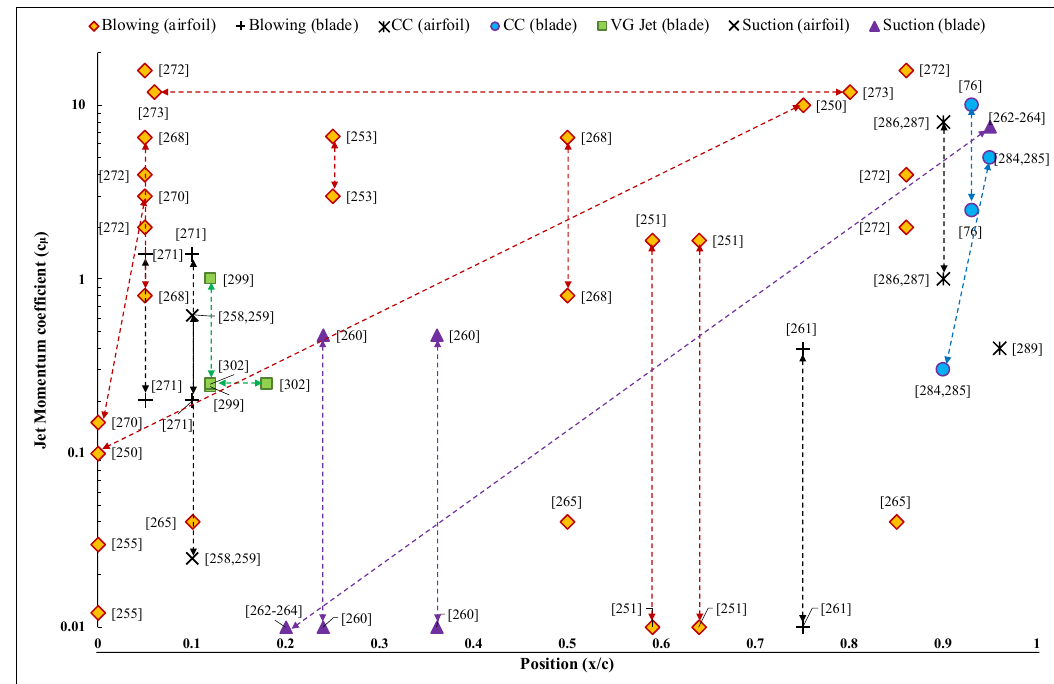
Figure 10. Literature survey of blowing-suction control. (The empty and filled markers correspond to the numerical and experimental investigations, respectively. The arrows correspond to the range of